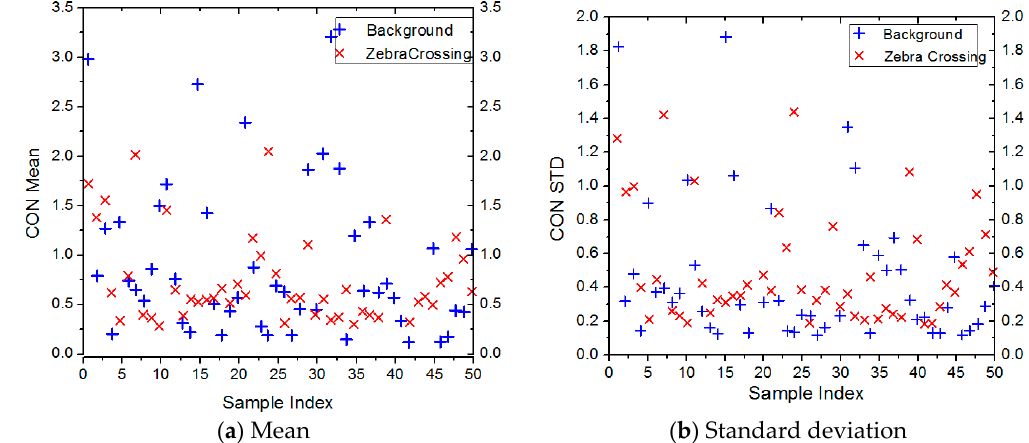
Figure 3. The results of Mean and standard deviation of contrast feature extracted from 50 zebra crossing samples (red crosses) and 50 background samples (blue crosses) based on the original images;